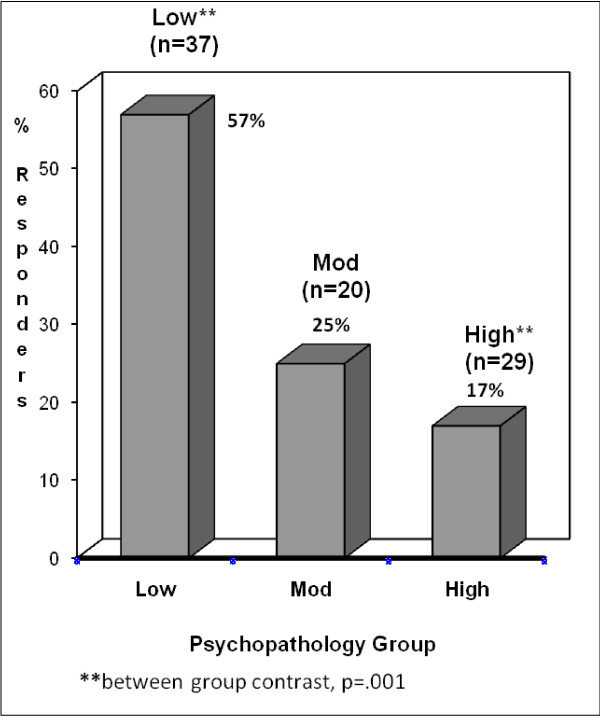
Percentage of Patients in Each Group with 20% Improvement. **between group contrast, p = .001